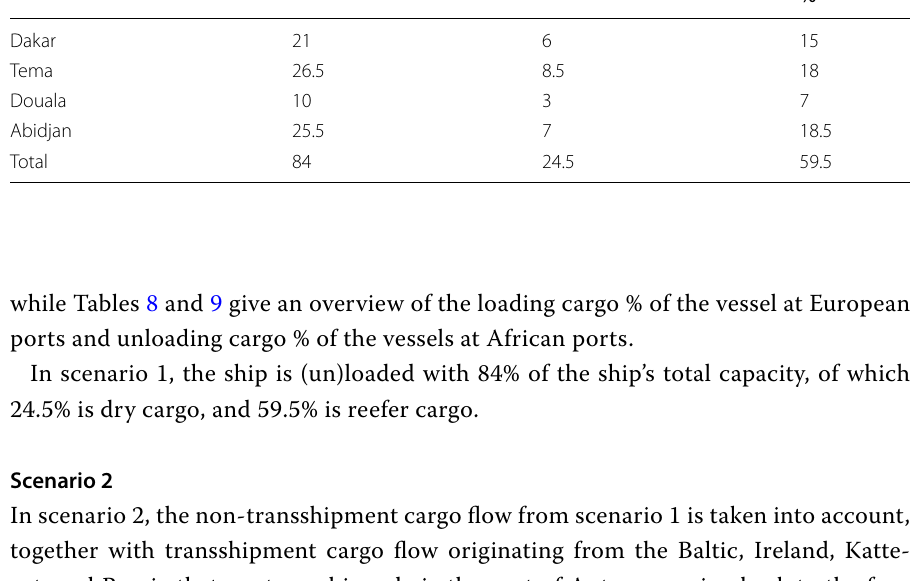
Table 9 Unloading cargo % of the vessel at African ports—scenario 1 Calling at port Total unloading